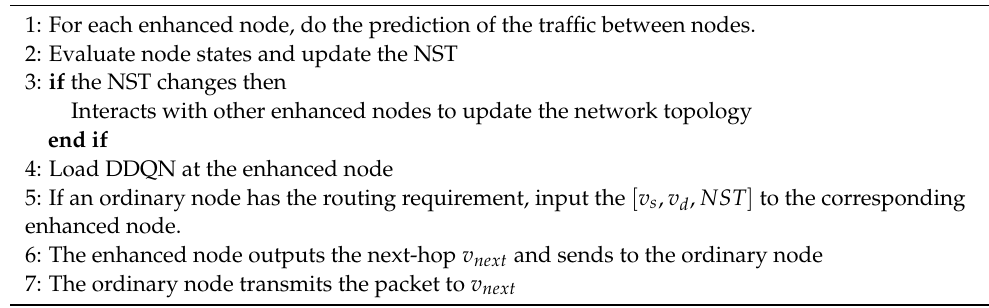
Algorithm 3 The Workflow of the MHSA-TFFDDPG algorithm